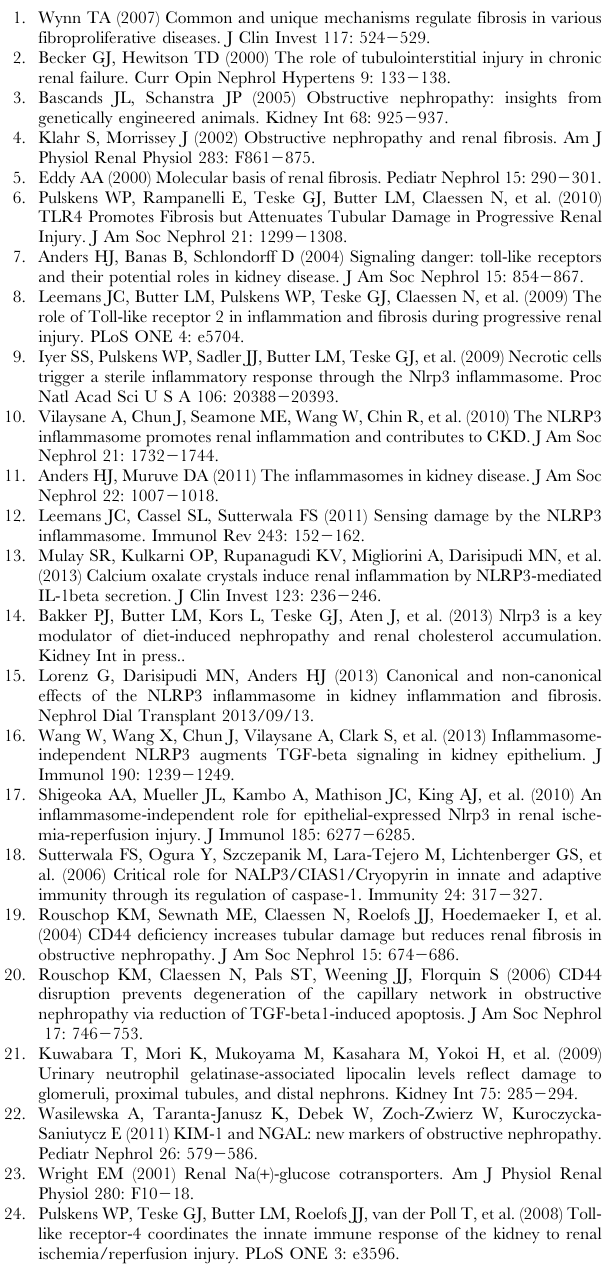
and Nlrp3 2 / 2 mice. Data are mean 6 SEM of 7 mice per group and indicated as pg per mg protein. Contral. = contralateral kidneys of mice subjected to 14 days of UUO. *:p ,